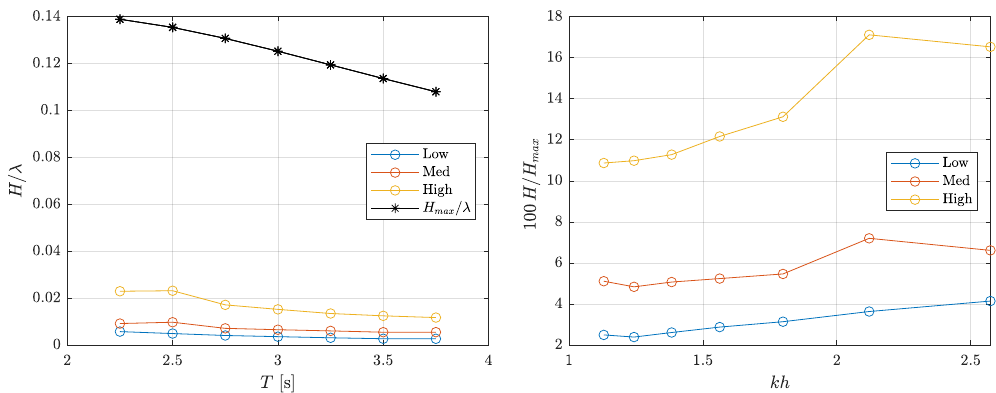
Figure 3. The test wave conditions in terms of nonlinearity, H / λ , relative water depth, kh , and the maximum possible wave steepness, H max / λ , as given by Reference [18].